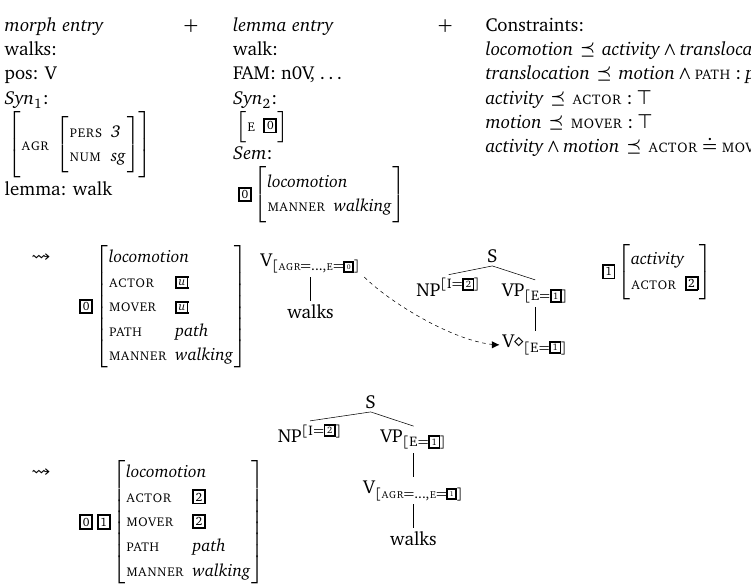
Figure 13: Morph and Lemma lexicons and lexical